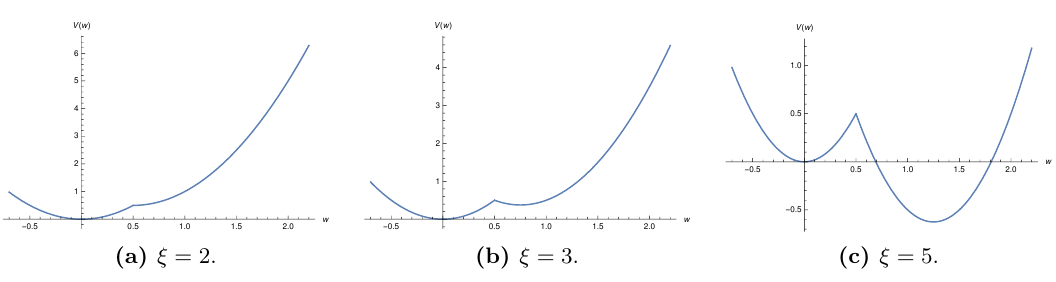
Figure 3 . Plot of the potential V ( w ) in (4.24) for (cid:18) = (cid:25)= 3 with (a) (cid:24) = 2, (b) (cid:24) = 3, and (c) (cid:24) =